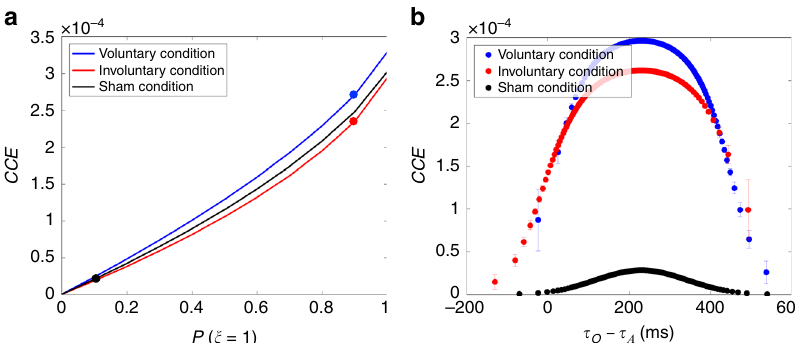
Fig. 4 Bayesian model predictions of the con fi dence in causal estimate ( CCE ), which is our proposed measure for SoA. a Our Bayesian model predicts CCE to increase with a stronger causal prior. Furthermore, CCE differs for each condition even with equal prior strengths. This can be attributed to the difference in the amplitude of the jitter in the self-generated vs TMS-induced movement (muscle twitches) and audible clicks. b When plotted as functions of the trial-to-trial temporal disparity τ O − τ A , with the speci fi c causal priors obtained for each condition, marked in a , CCE has a higher peak in the voluntary condition, but much lower values in the sham condition. Furthermore, CCE diminishes as the temporal disparity in sensory inputs moves further away from the prior mean | τ O − τ A − μ AO |. This falling of the CCE is faster when the causal prior is weaker and the uncertainty in the action input signal